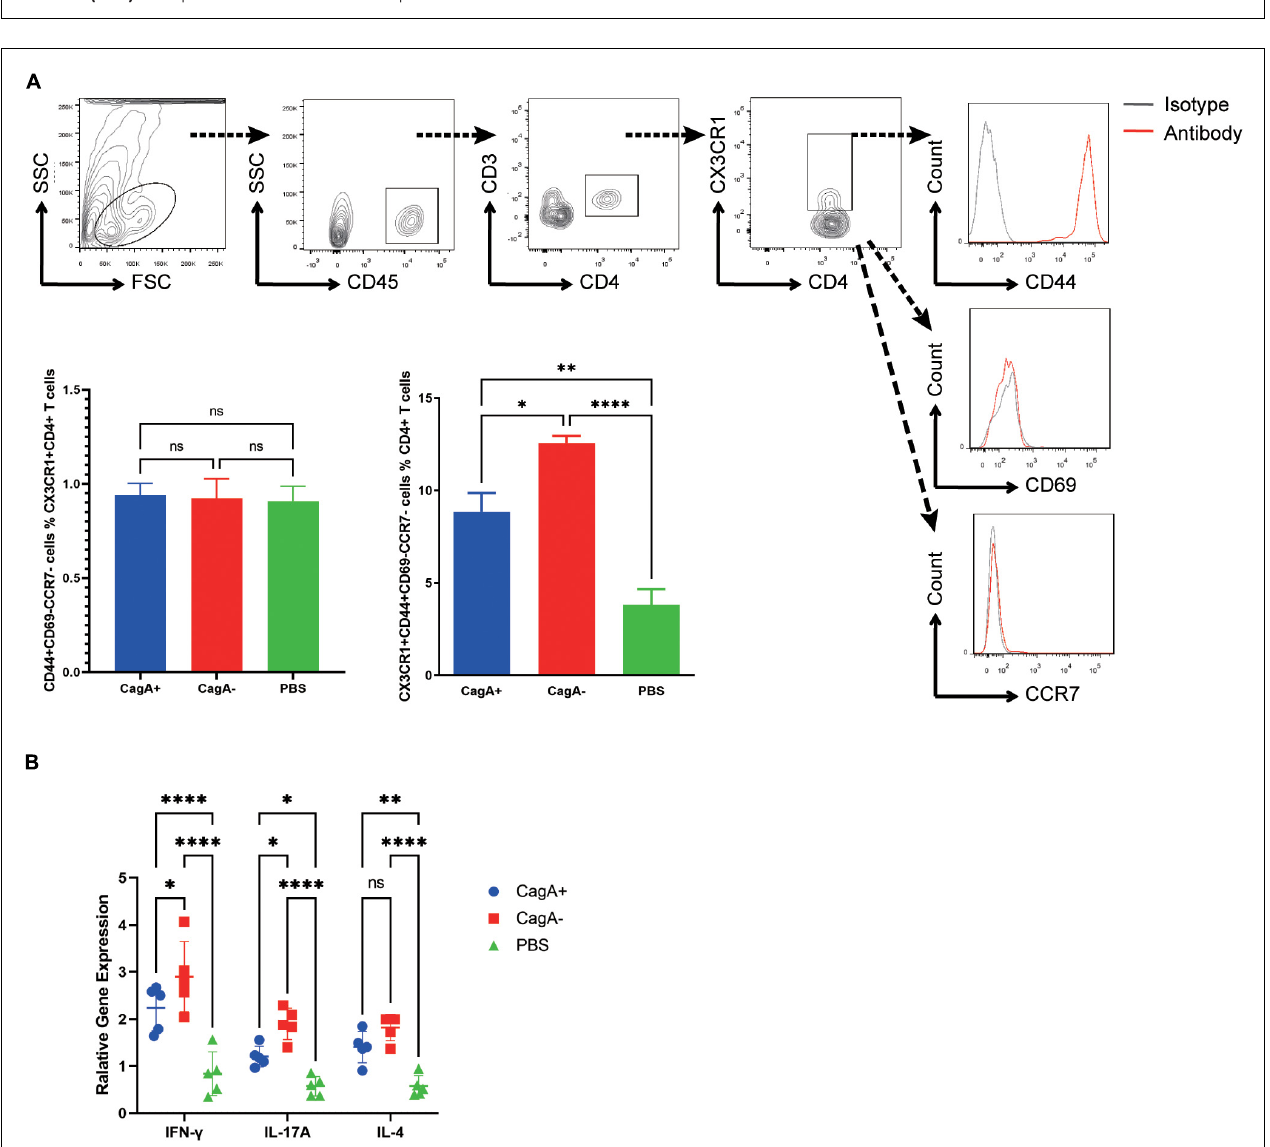
FIGURE 4 | Phenotype of mucosal CX3CR1 + CD4 + T cells in H. pylori- infected mice. Mice were infected with H. pylori strain NCTC11637 (CagA + ) or its isogenic mutant (cid:49) cagA NCTC11637 (CagA − ) by intragastric administration. PBS was used as the control. Four weeks later, stomachs were harvested. (A) The expression of CD45, CD3, CD4, CX3CR1, CD44, CD69, and CCR7 in gastric cells was assessed. The percentages of CD44 + CD69 − CCR7 − population in gastric CX3CR1 + CD4 + T cells and percentages of CD3 + CD4 + CX3CR1 + CD44 + CD69 − CCR7 − population in gastric CD4 + T cells are shown. (B) The expression levels of IFN- γ , IL-17A, and IL-4 in sorted CX3CR1 + CD4 + T cells from H. pylori -infected mice stomachs were determined by quantitative real-time PCR. β -actin was used as the reference gene. Data are shown as mean ± SD. N = 5, ∗ p < 0.05, ∗∗ p < 0.01, and ∗∗∗∗ p < 0.0001. Results are representative of four individual